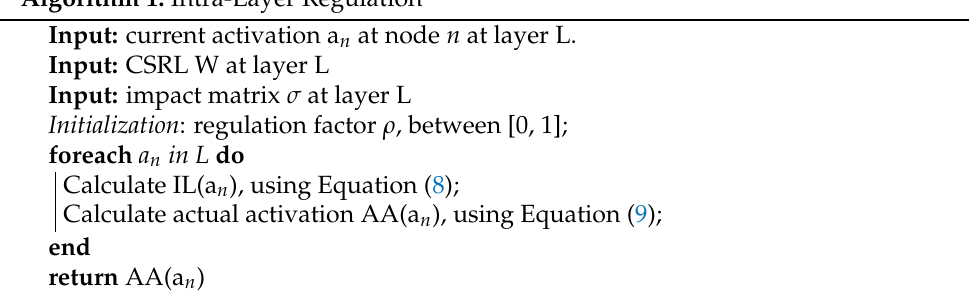
Algorithm 1: Intra-Layer